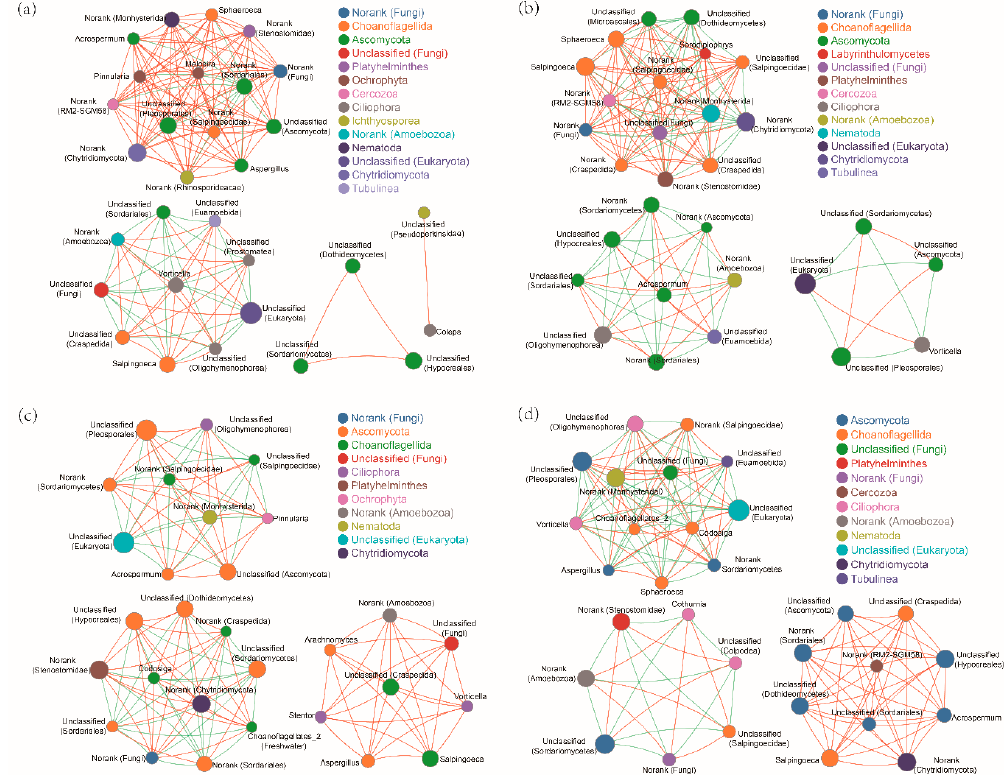
Figure 4. An overview of fungal networks at the genus level in different treatment groups: ( a ) natural light simulation group without Pb (N); ( b ) ALAN simulation group without Pb (A); ( c ) natural light simulation group with Pb (N-Pb); and ( d ) ALAN simulation group with Pb (A-Pb). Sizes and colors of the nodes represent the relative abundance of the fungi. Solid lines in red and green denote positive and negative correlations, respectively. The width reflects the strength of the